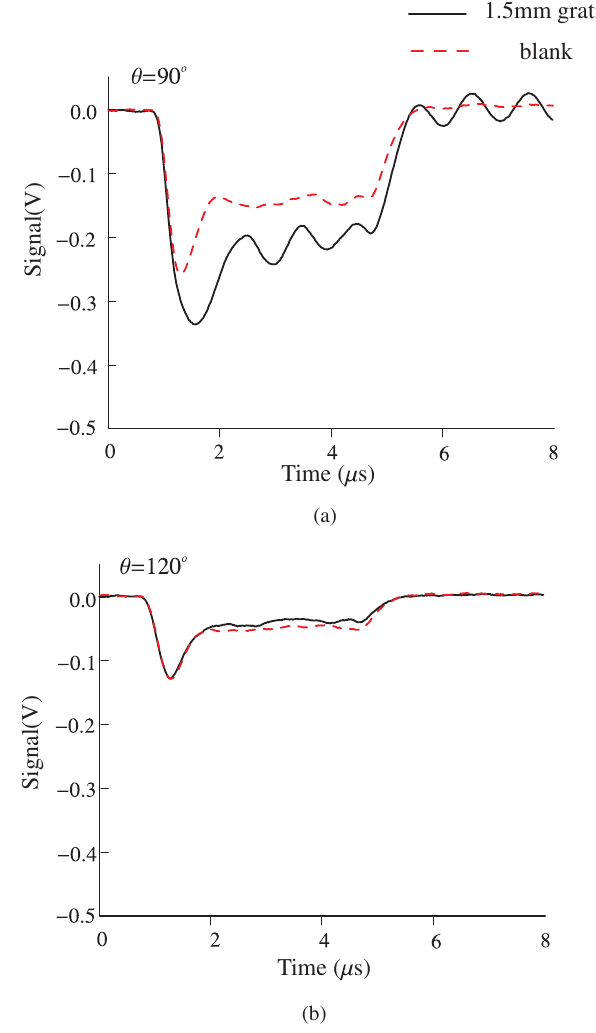
FIG. 5. (Color) (a) Detector output from the 1.5 mm grating and from the blank, using the same set of filters. (b) Detector output from a port sealed with a thick Al plug. The signal is due to x rays (see text for